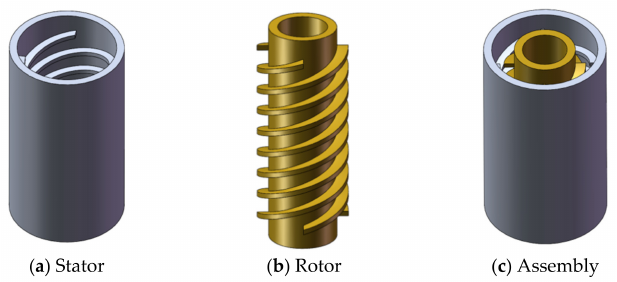
Figure 1. Structure and assembly of stator and rotor.